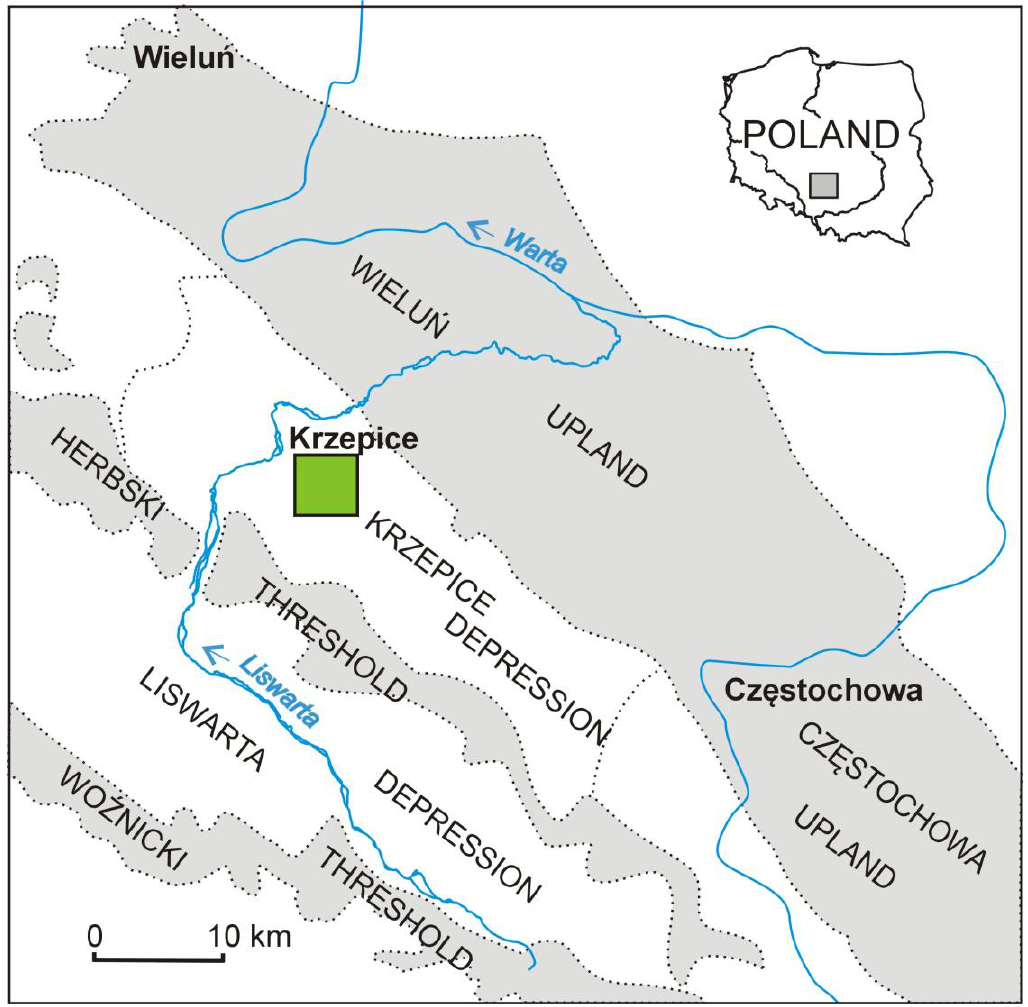
Fig. 1. Study area location marked with a green square with respect to the neighbouring physicogeographical